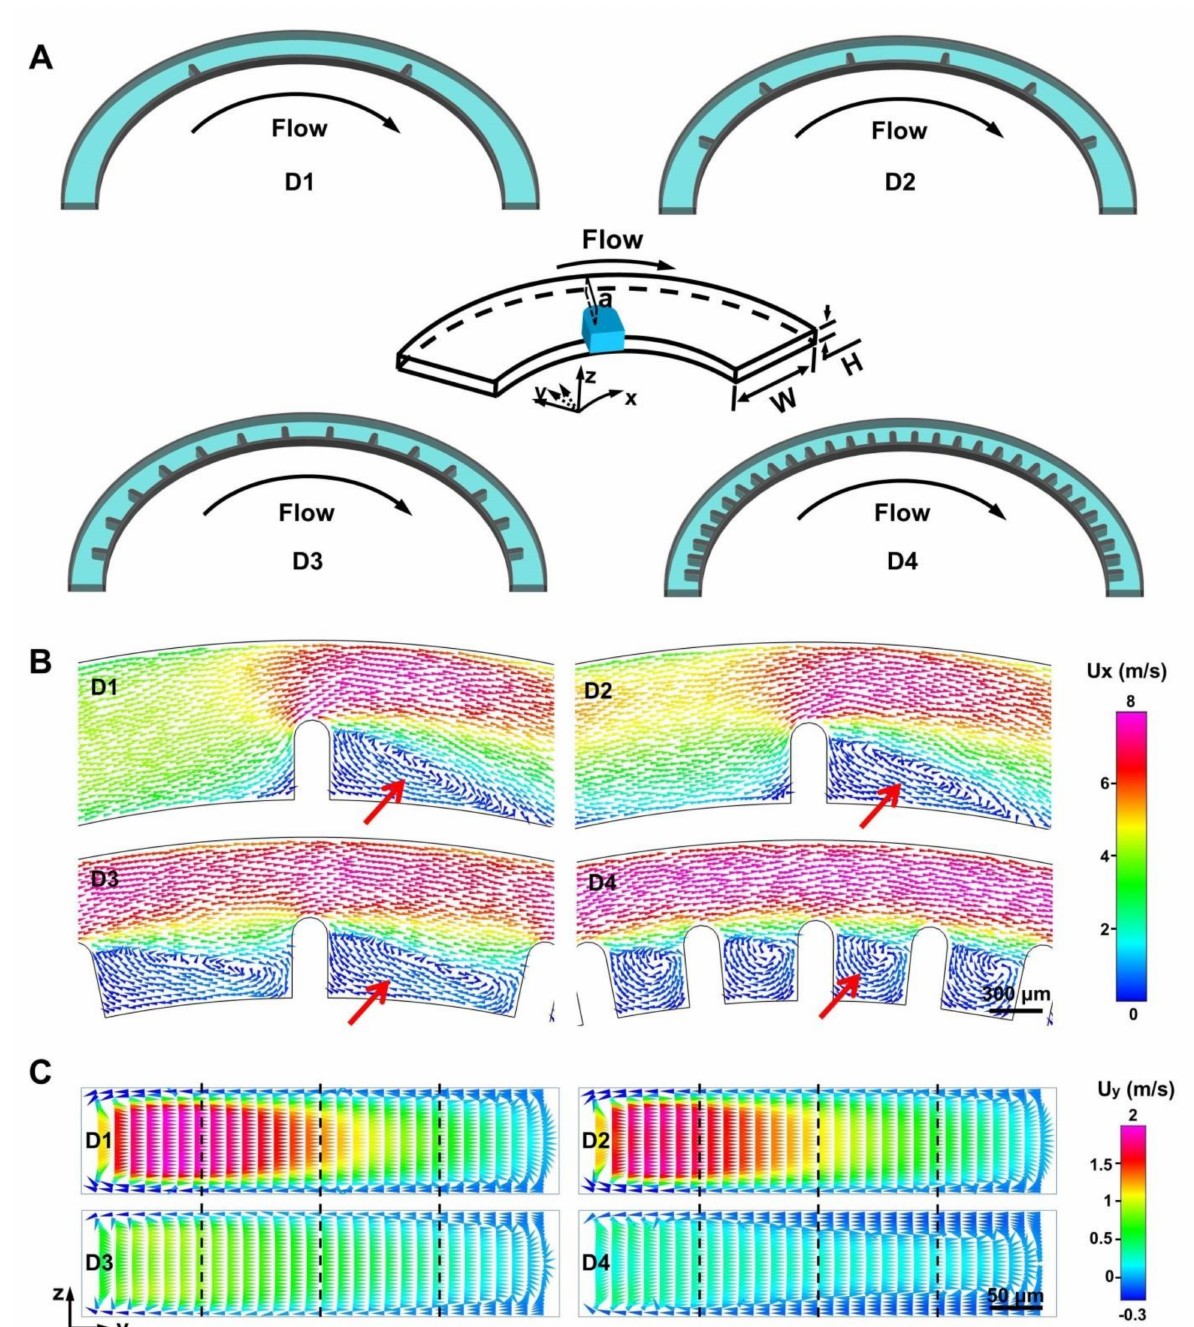
Figure 1. Multi-vortex regulation based on dimensional confinement. ( A ) Configuration of the four dimension-confined curved microfluidic channels (D1, D2, D3, D4). The D-channels are equipped with different amounts of ordered micro-bars. In the D-channels, the narrow regions are all 450 µ m wide, and the wide regions are all 900 µ m wide. The channel heights are 100 µ m. ( B ) Representative helical vortex induced by micro-bars along the D-channels (D1, D2, D3, D4) under flow rates of 15 mL min − 1 . The red arrows represent different vortex distributions. ( C ) Simulated demonstration of the Dean flow acceleration in the y-axis along channel cross sections of the narrow regions of the D-channels (D1, D2, D3, D4). The flow rate is 15 mL min –1 . To evaluate the local flow field quantitatively, the section is divided into four